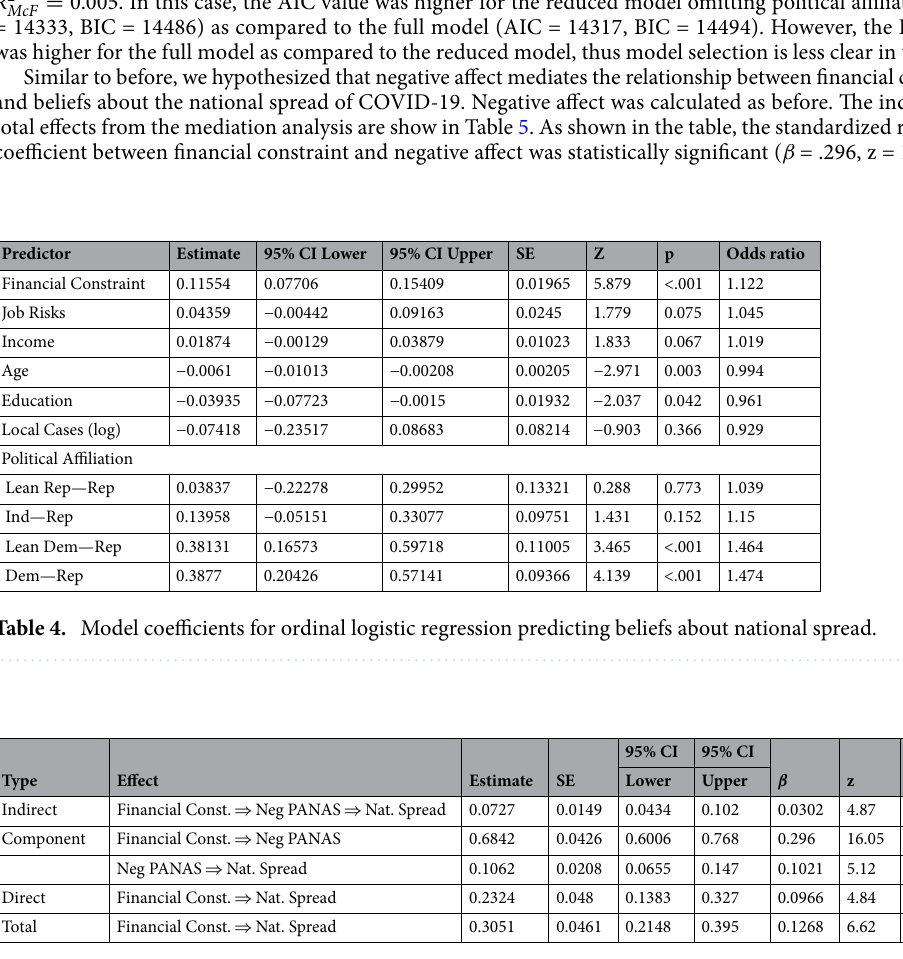
Table 5. Indirect and total effects for national spread mediation model. Confidence intervals computed with method: Standard (Delta method). Betas are completely standardized effect sizes.